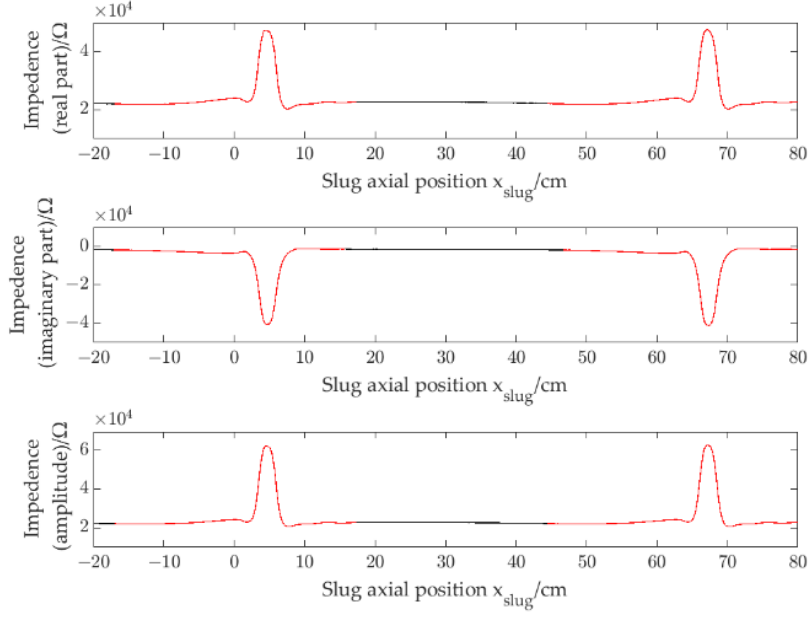
Figure 8. The marked results of impedance signals.